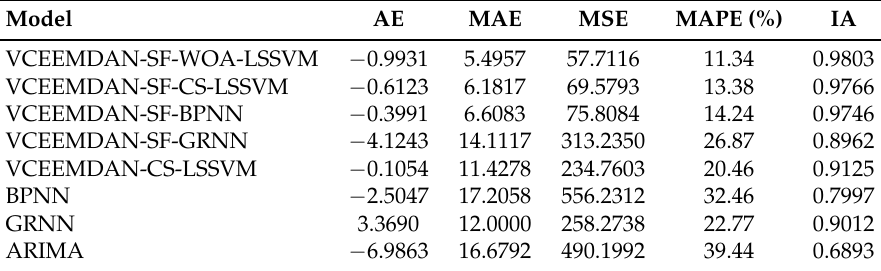
Table 6. Experiment II forecasting results in Beijing.